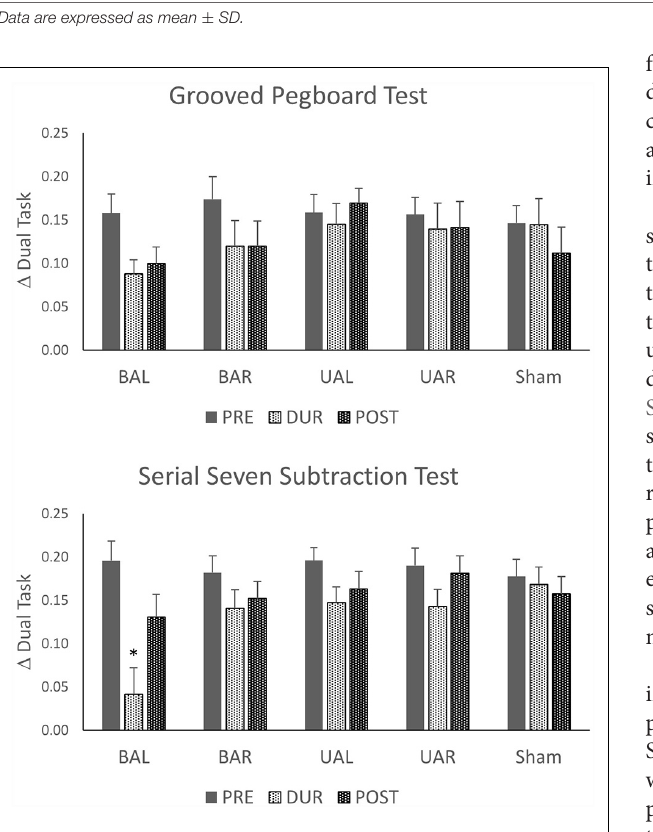
FIGURE 2 | Changes from single- to dual-task condition calculated as change in dual task ( ∆ ) = (number in the single task − number in dual tasks)/number in a single task. Stimulation tDCS montages: unilateral (Ul), bilateral (Bl), sham stimulation of dorsolateral prefrontal cortex (DLPFC) with anode left (AL) and anode right (AR). ∗ p <